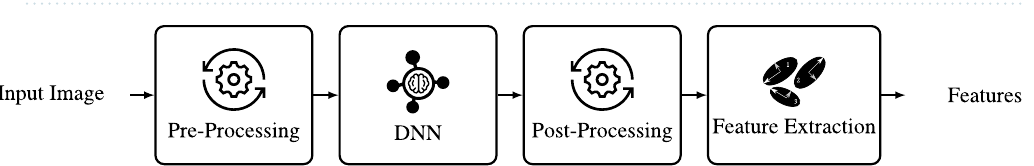
Figure 6. Automated Object Detection Pipeline. The input image is pre-processed before being fed into a DNN. Then, the DNN prediction is post-processed to obtain objects described by different properties using feature extraction.